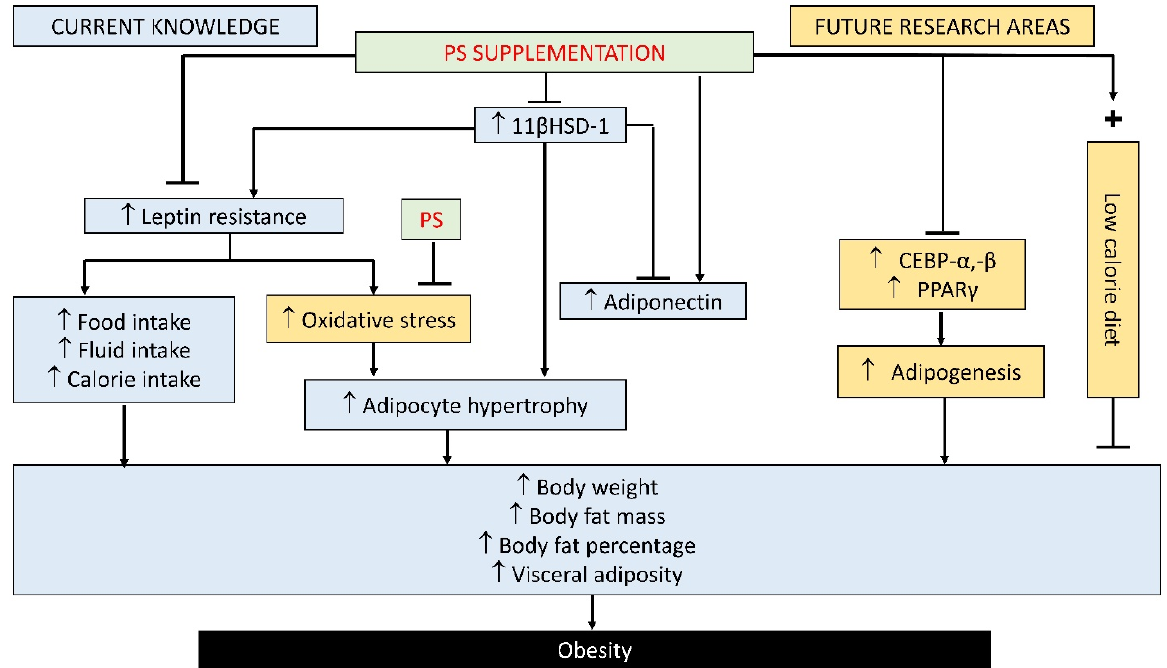
Figure 2. Protective effect of PS supplementation against obesity: current knowledge and future area of investigation. List of abbreviations: PS, Piper sarmentosum ; 11 β HSD-1, 11 β -hydroxysteroid dehydrogenase type 1; CEBP- α , - β , CCAAT/enhancer-binding protein; PPAR- γ , peroxisome proliferator activator receptor-gamma; ↑ , increase; +, in combination with.